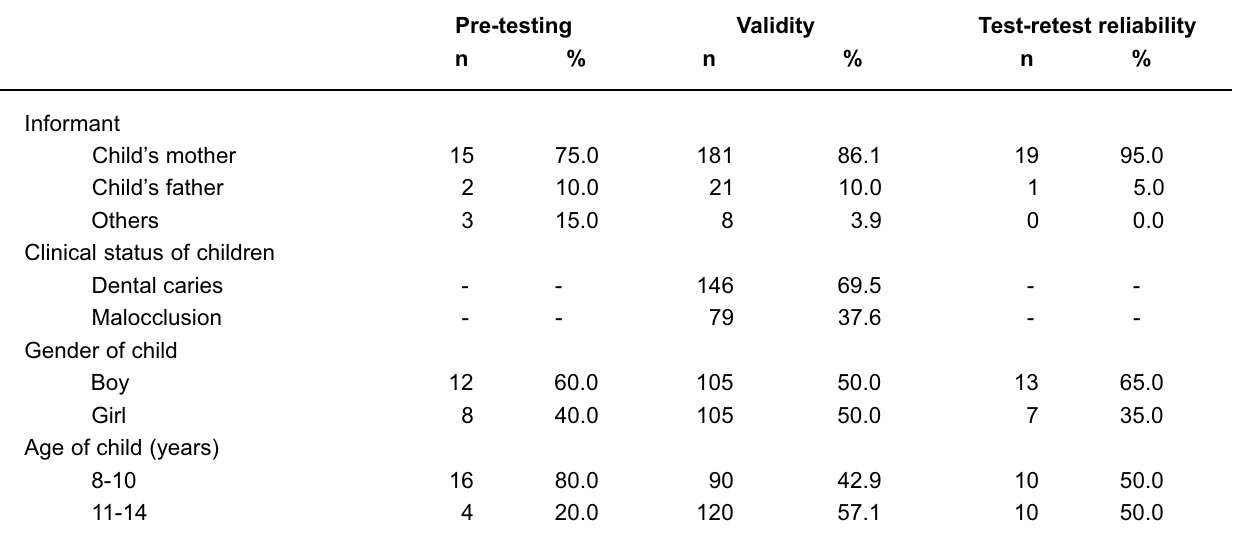
Adapted from Locker et al .